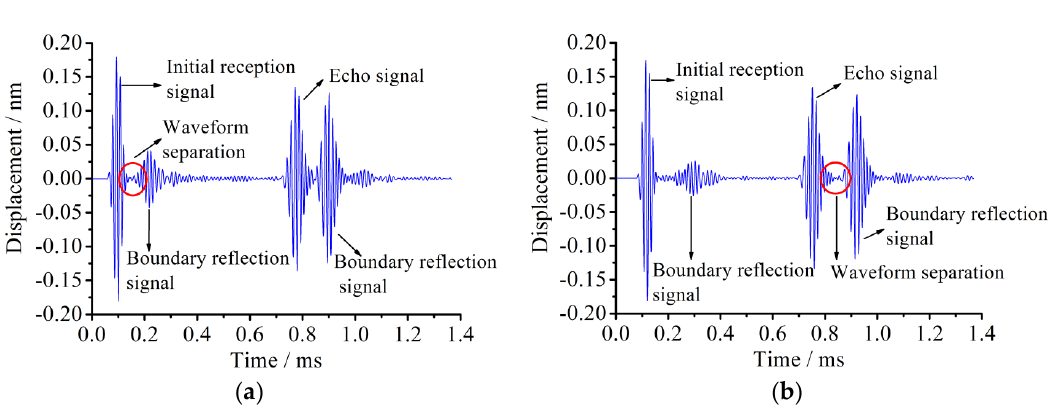
Figure 8. The nodal displacement signal at the beginning of separation of the incident wave and reflection wave in the simulation. ( a ) Initial reception signal; ( b ) First echo signal.